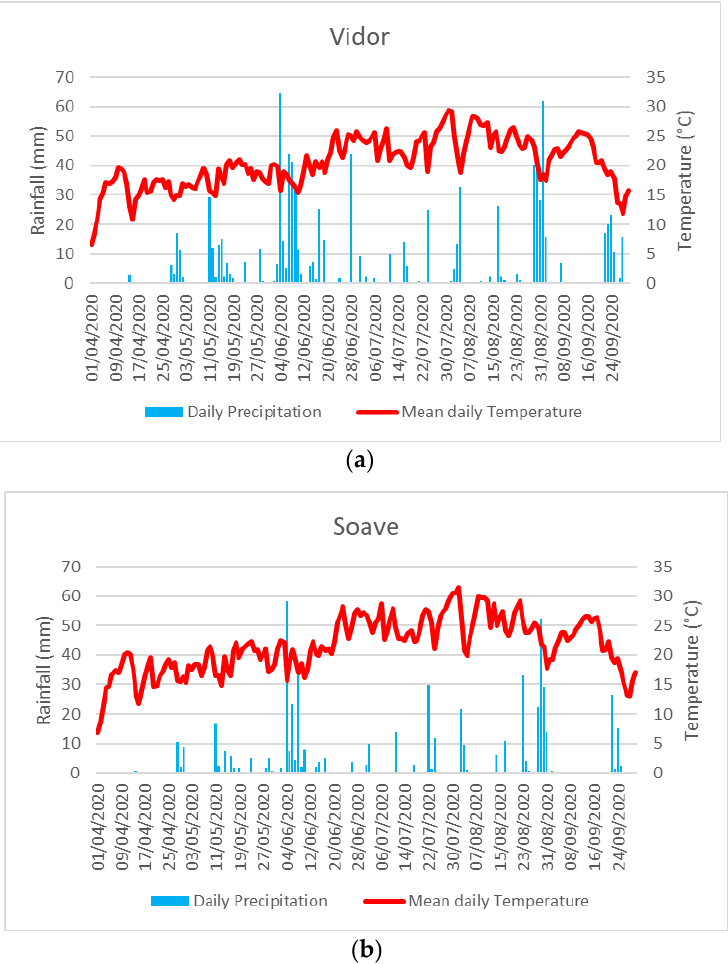
Figure 4. Mean daily temperature and precipitation in the Vidor ( a ) and Soave ( b ) vineyards in 2020. To evaluate the performance of the pesticides, the response of the plants to downy mildew disease was analyzed regularly at each growth stage (BBCH-identification keys of grapevine), following the developmental scale described by Lorenz et al. (1994). We scored 100 leaves and 100 bunches picked randomly from 10 central plants of each plot and estimated the percentage of affected organs (disease incidence) and the percentage areas of leaves and bunches showing disease symptoms (disease severity). For the evaluation of the damage in each site, 50 leaves/bunches were sampled randomly from central plants of each plot. The first and the last rows of the vineyards were excluded from sampling to create a buffer zone between the experimental areas and the surrounding vineyards. In Vidor, four plots for FSS and SG, and the UTC, were sampled. In Soave, due to the different arrangement of the FSS, three plots for FSS and ABS, and the UTC, were sampled. Disease severity (infection degree (ID)) was calculated using a scale of eight classes (0–7) with the